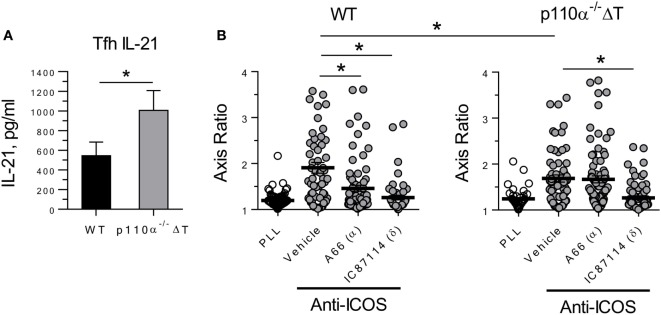
PI3-kinase 110α-deficient Tfh cells show enhanced secretion of the effector cytokine IL-21 (A), but partially impaired ICOS-induced elongation (B). Naive CD4+ T lymphocytes from WT or p110α-T cell deficient (p110α−/−ΔT) mice were differentiated for 4 days “in vitro” with anti-CD3 plus anti-CD28 antibodies under Tfh conditions. Then, culture supernatants were analyzed for IL-21 (A), or ICOS-induced elongation of Tfh cells was determined (B), as indicated. Mean ± SE of four experiments (A). In (B), the elongation of WT or p110α-T cell-deficient Tfh cells was determined as the axis ratio in the presence of plate-bound Poly-L-Lys (PLL) or anti-ICOS, as indicated. The cultures received vehicle (DMSO), or inhibitors specific for PI3-kinase p110α (A66, 1 µM) and p110δ (IC87114, 5 µM). Mean ± SE of elongation in >50 individual cells. Significant differences (*p < 0.05; ***p < 0.001) were determined using the Student’s t-test.